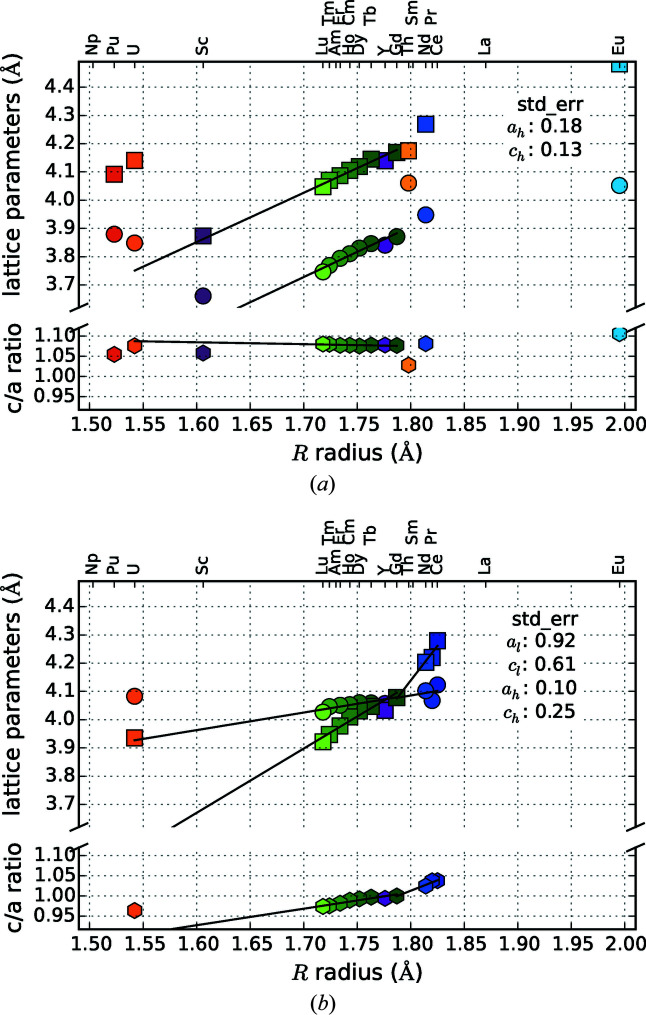
Influence of the radius of the R element on compounds with identical valence electron amount and constant T element. (a) hexagonal RSi2 compounds and (b) hexagonal R
2PdSi3 compounds. The color changes with the atomic number of the R element, according to the color code from the correlation plots. Additionally, the element symbols are given at the top of the diagrams. The markers symbolize lattice parameter a (circle), lattice parameter c (square) and the ratio c/a (hexagon). The standard error is given for the indicated regression lines of the a and the c parameter, separated according light and heavy lanthanides (h and l, respectively). The color code is adapted from the correlation plots.